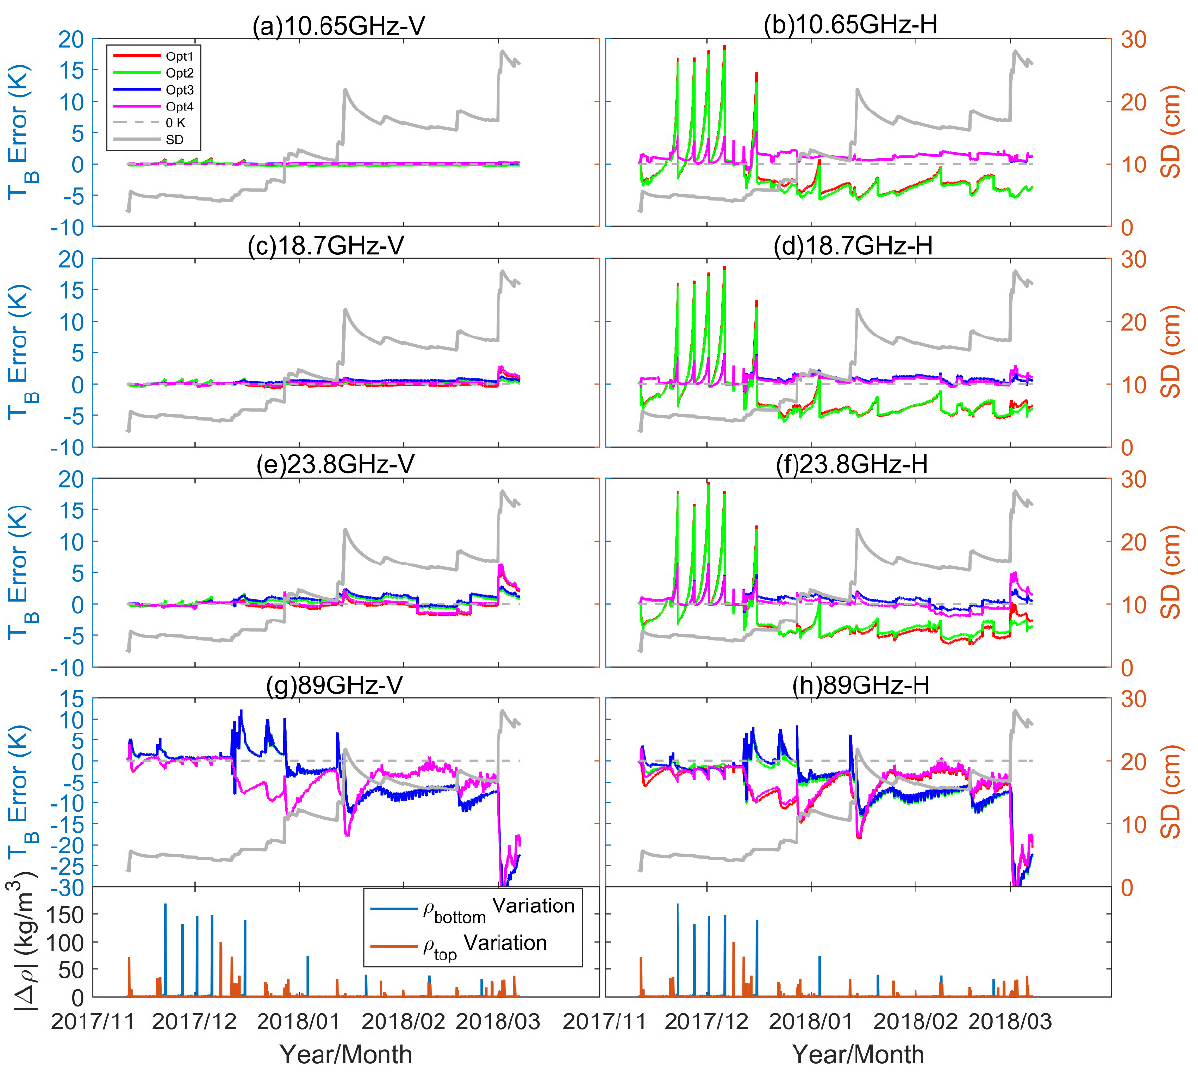
Figure 8. Error of the simulated brightness temperature (T B ) based on four different calculation methods at other frequencies: ( a , b ) 10.65 GHz, V and H pol.; ( c , d ) 18.7 GHz, V and H pol.; ( e , f ) 23.8 GHz, V and H pol.; and ( g , h ) 89 GHz V and H pol.; and difference ( | ∆ ρ | ) in density of topmost ( ρ top )/bottommost ( ρ bottom ) snow layer between two adjacent samples, together with snow depth (SD), in time series.